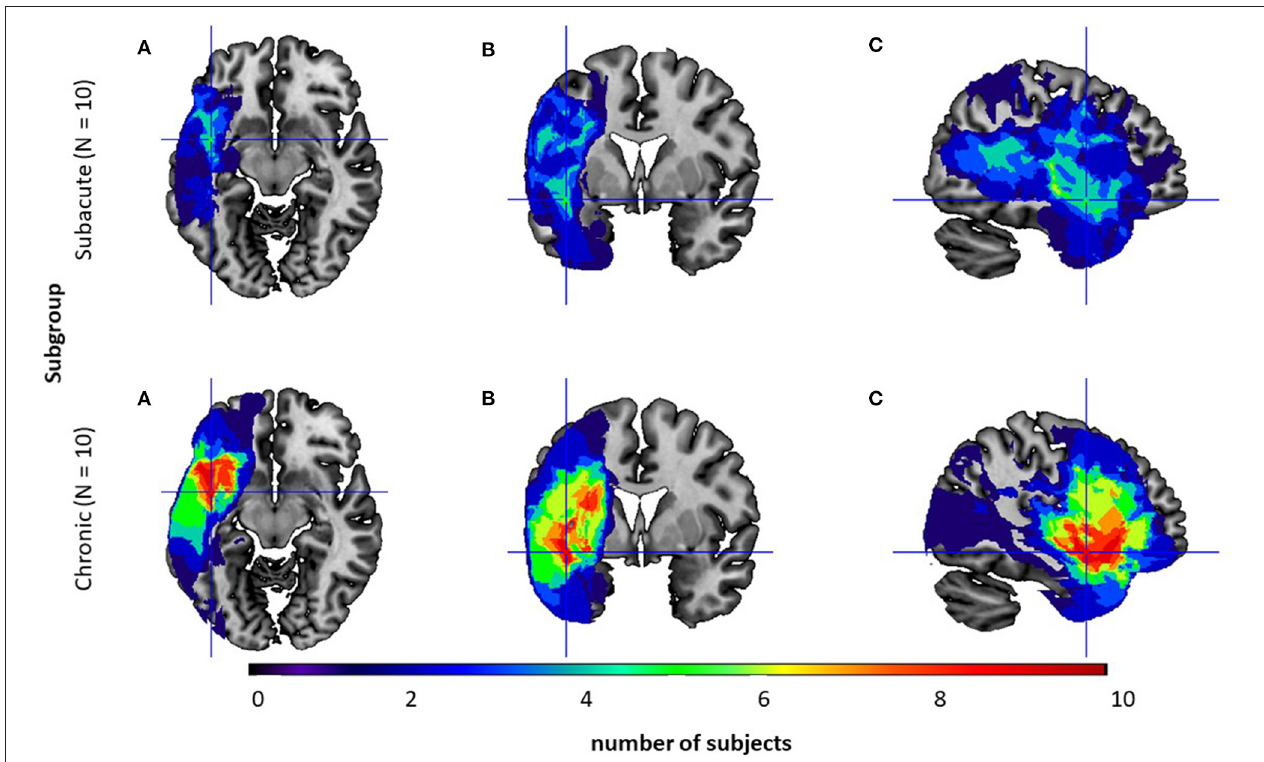
FIGURE 1 | Overlay of the participants’ normalized lesion reconstructions on a common brain template in three sections: (A) axial, (B) coronal, and (C) sagittal for two subgroups: the subacute subgroup (top level) and the chronic one (bottom level). Brighter areas (red, orange, yellow, and green) indicate regions of greater overlap, while darker areas (blue and dark blue) indicate lesser